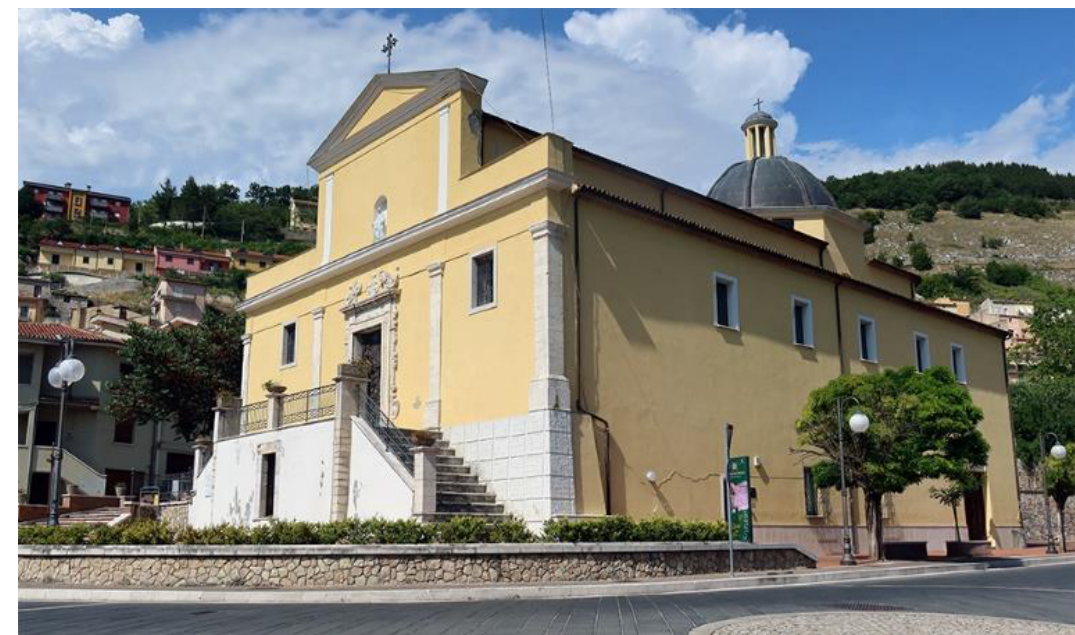
Figure 33. Santomenna: S. Maria delle Grazie church (photos by [35,36]).